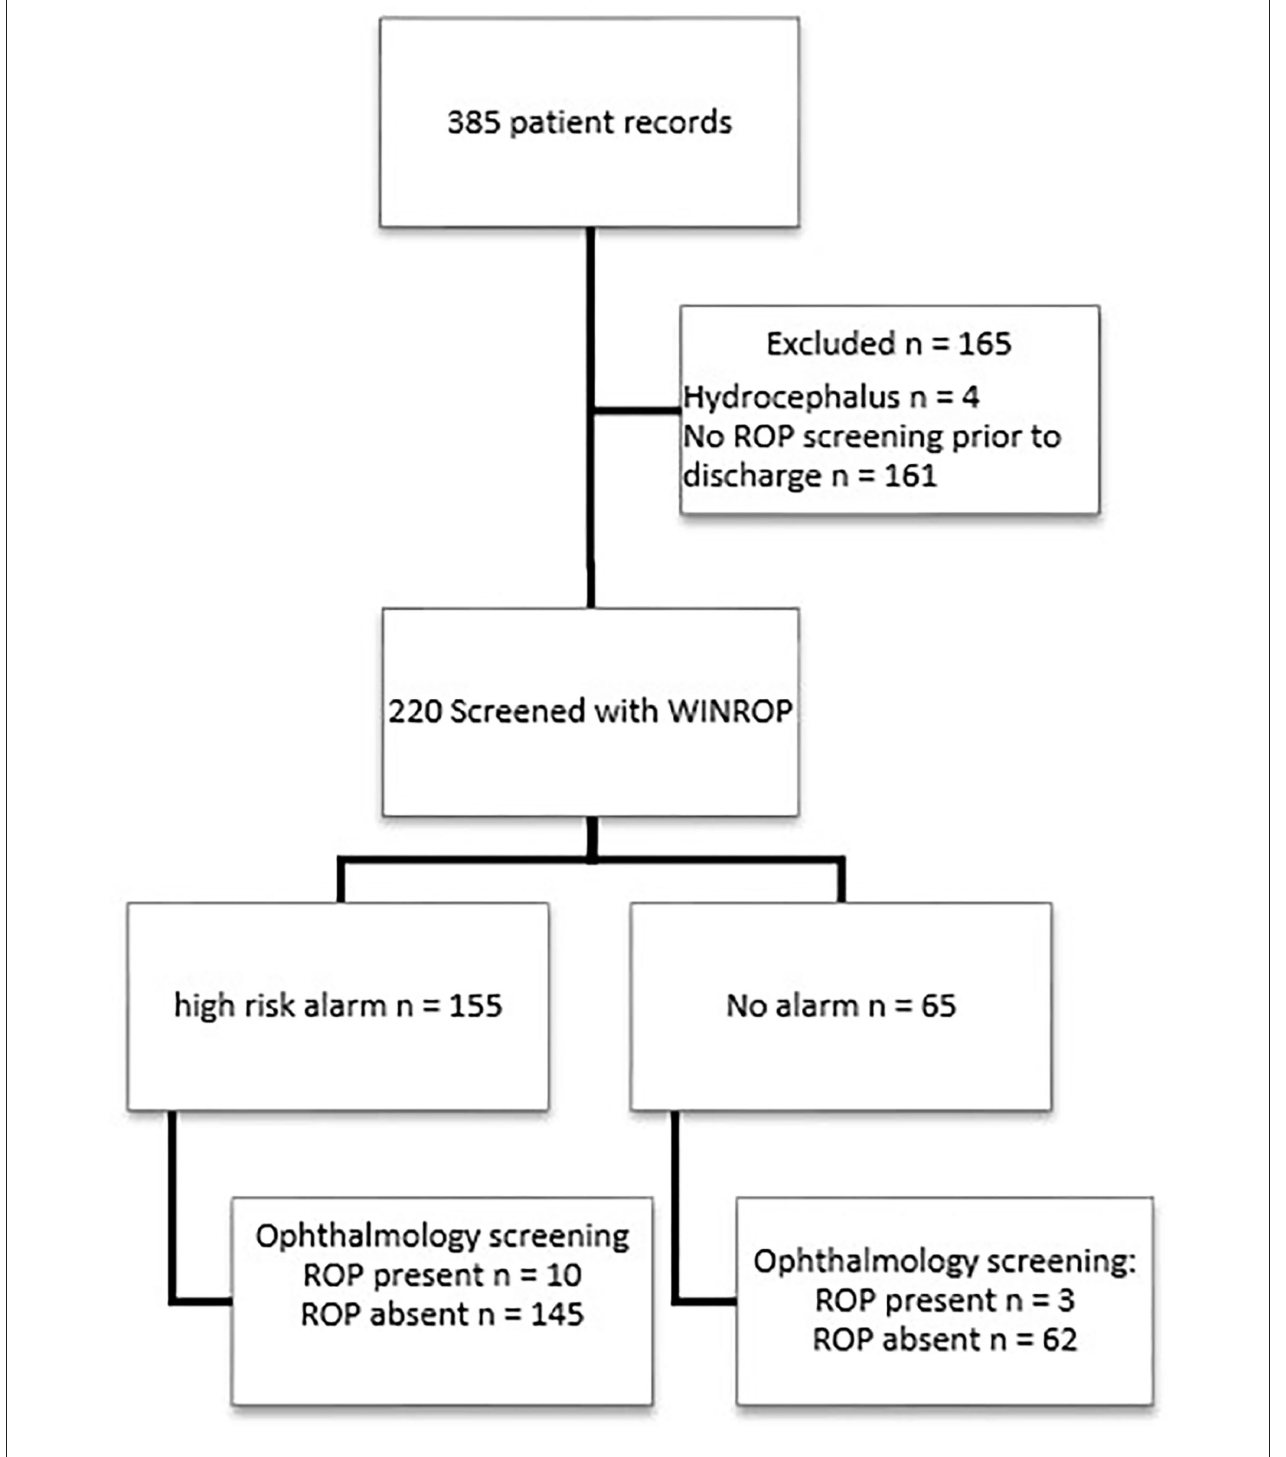
FIGURE 1 | Flow of